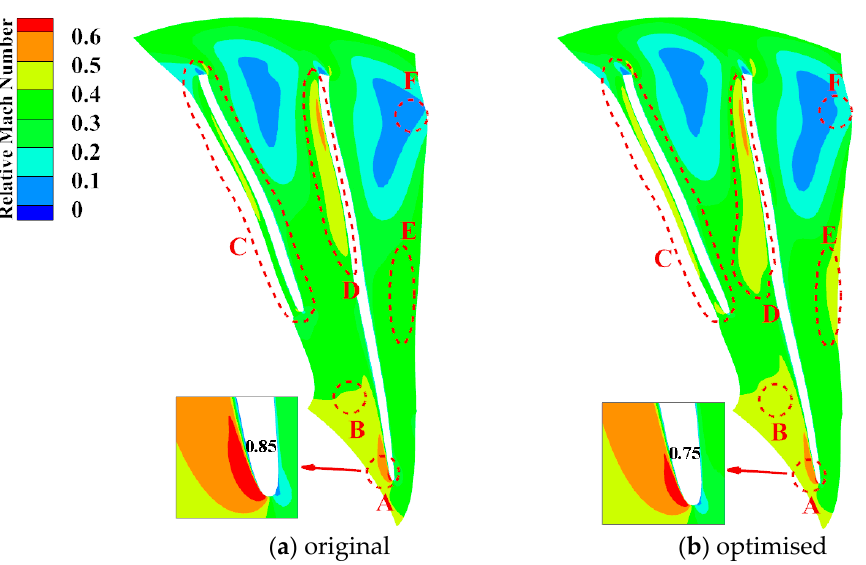
Figure 19. Comparison of the entropy contour of B2B surface at 80% height before and after optimisation (common operating condition).